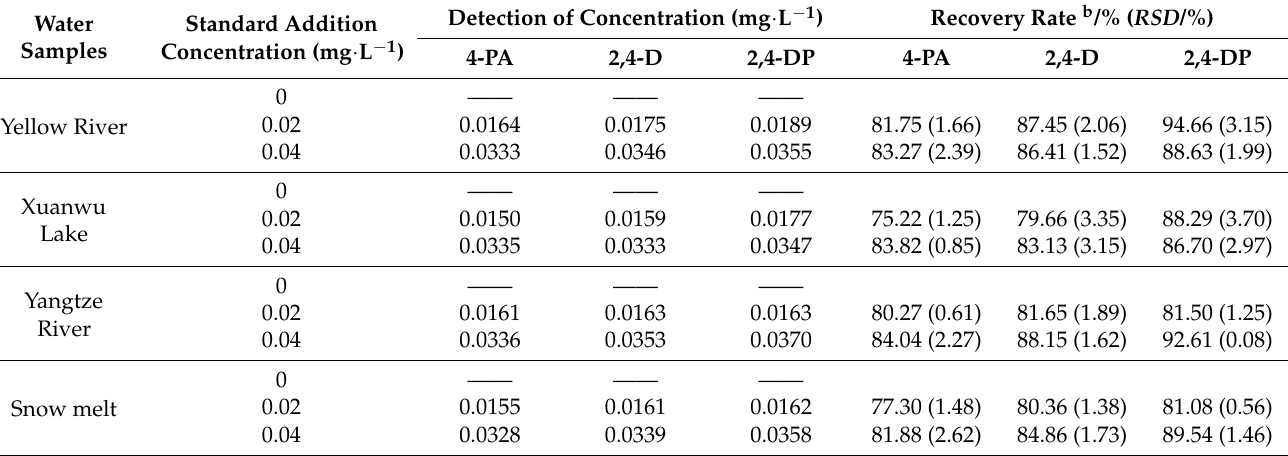
Table 3. The recovery and RSD of the three analytes in real water samples (na = 3).